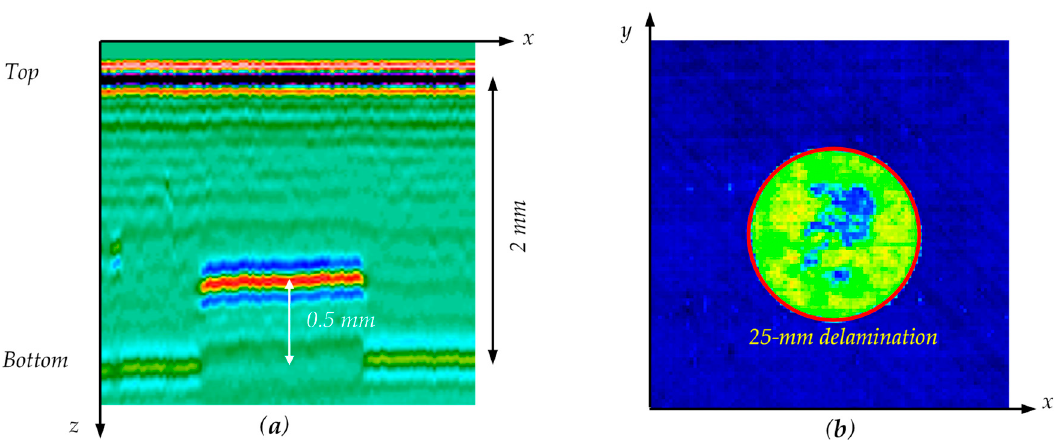
Figure 4. Ultrasonic nondestructive testing (NDT) inspection results showing the delamination simulated by the Teflon insert: ( a ) B-scan image; ( b ) C-scan image.